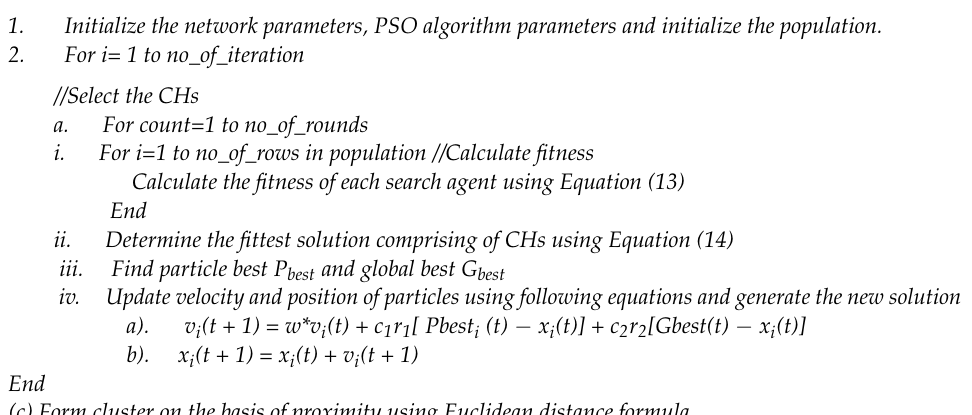
Algorithm 4 : PSO Euclidean-distance-based cluster formation